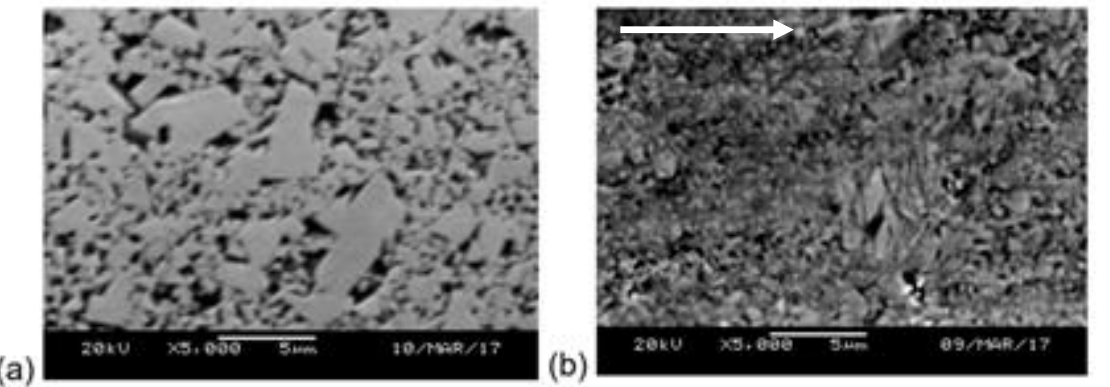
Figure 4. SEM micrographs of grade C of Table 1: ( a ) pristine surface, ( b ) after abrasion test (the arrow shows the friction direction).